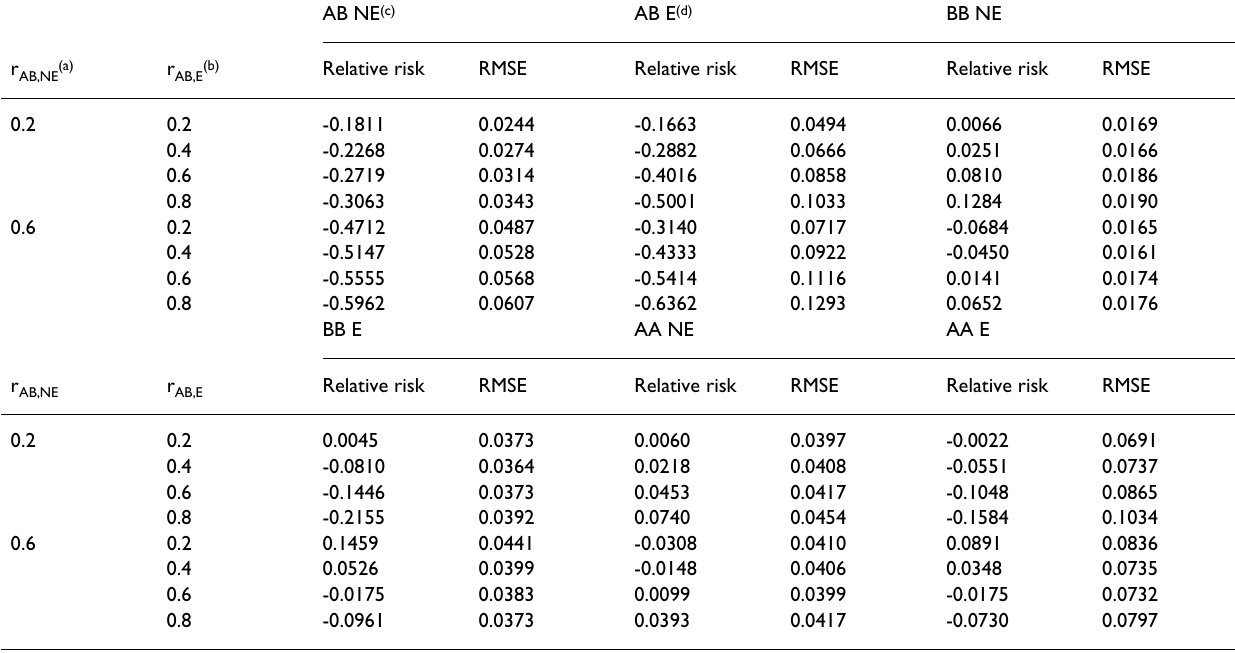
Table 3: Relative bias and RMSE of the disease risks predicted using the reduced model in the second scenario.